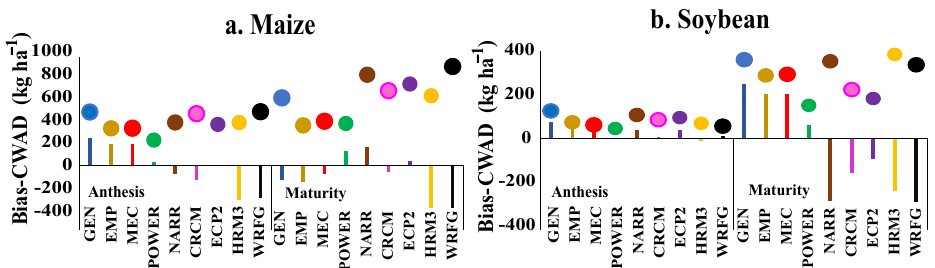
Figure 10. Root mean squared error (RMSE, colored circles) and mean error (ME, colored bars) of accumulated crop dry weight (CWAD) for the different sources of estimated solar radiation at the start date of planting, emergence, anthesis, and maturity for maize ( a ) and soybean ( b ). See Figure 2 for definition of abbreviations.